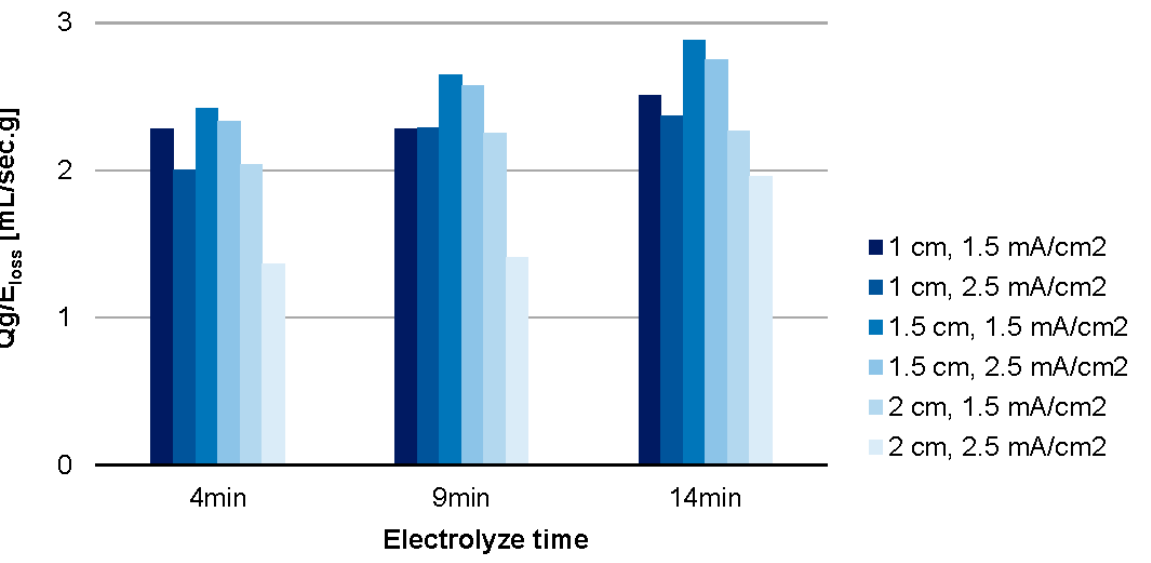
Figure 3. Qg/E loss value at different electrolyze times (4–14 min), electrode gaps (1–2 cm), and current densities (1.5–2.5 mA/cm 2 ).